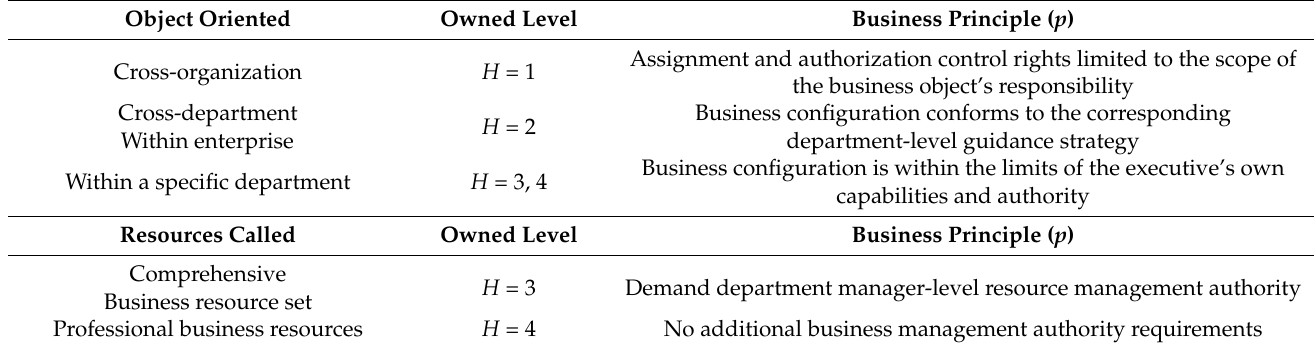
Table 1. Business principle at all